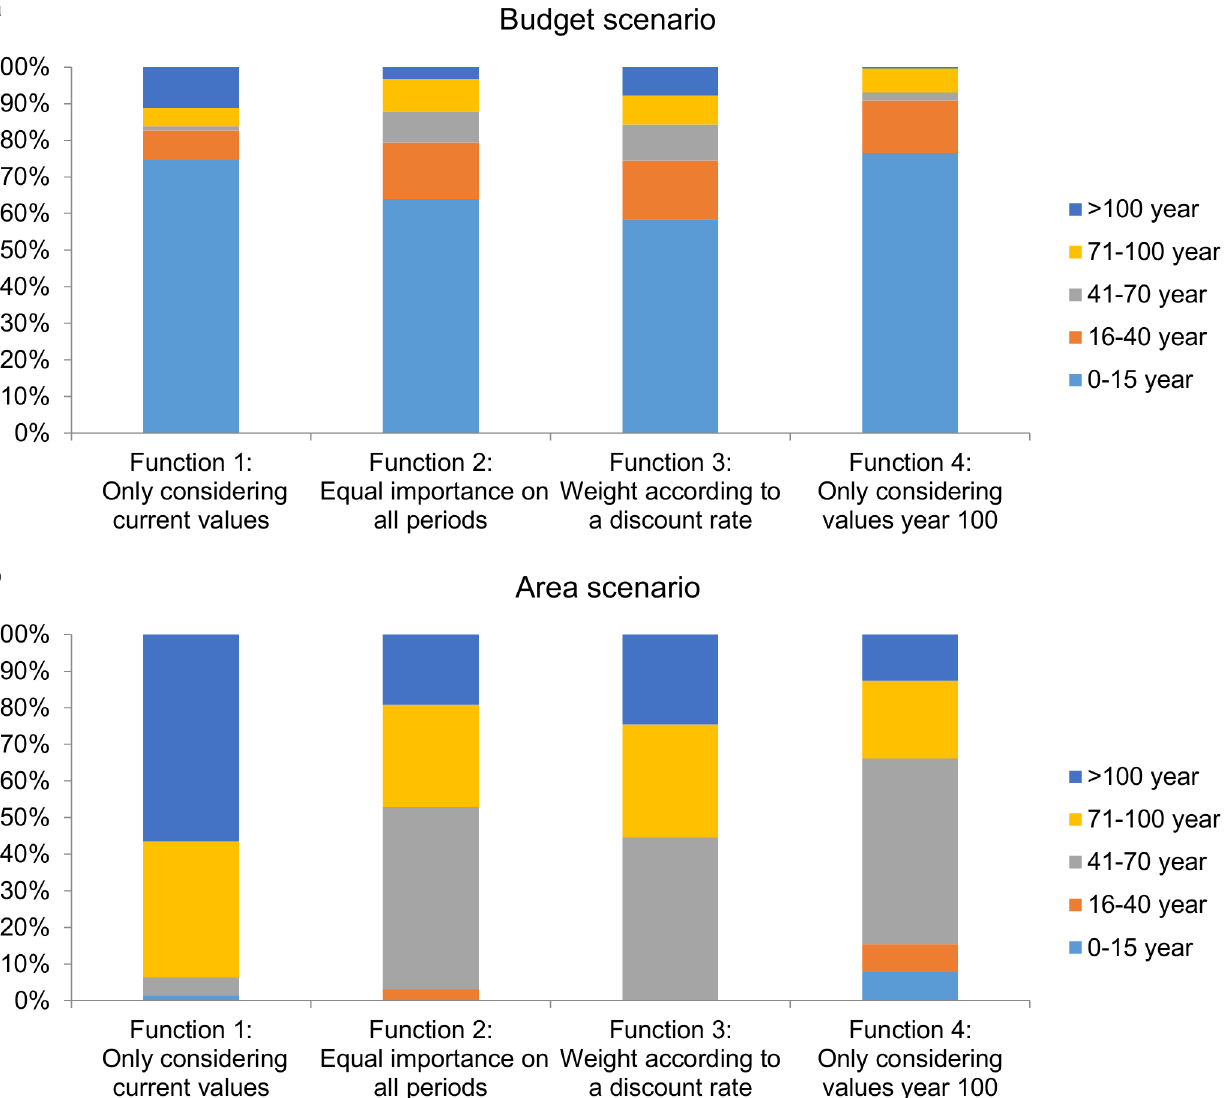
Fig 3. Optimal age distribution of reserves in boreal Sweden obtained by applying the four variants of the discount function in (a) the budget-constrained selections and (b) the area-constrained selections.